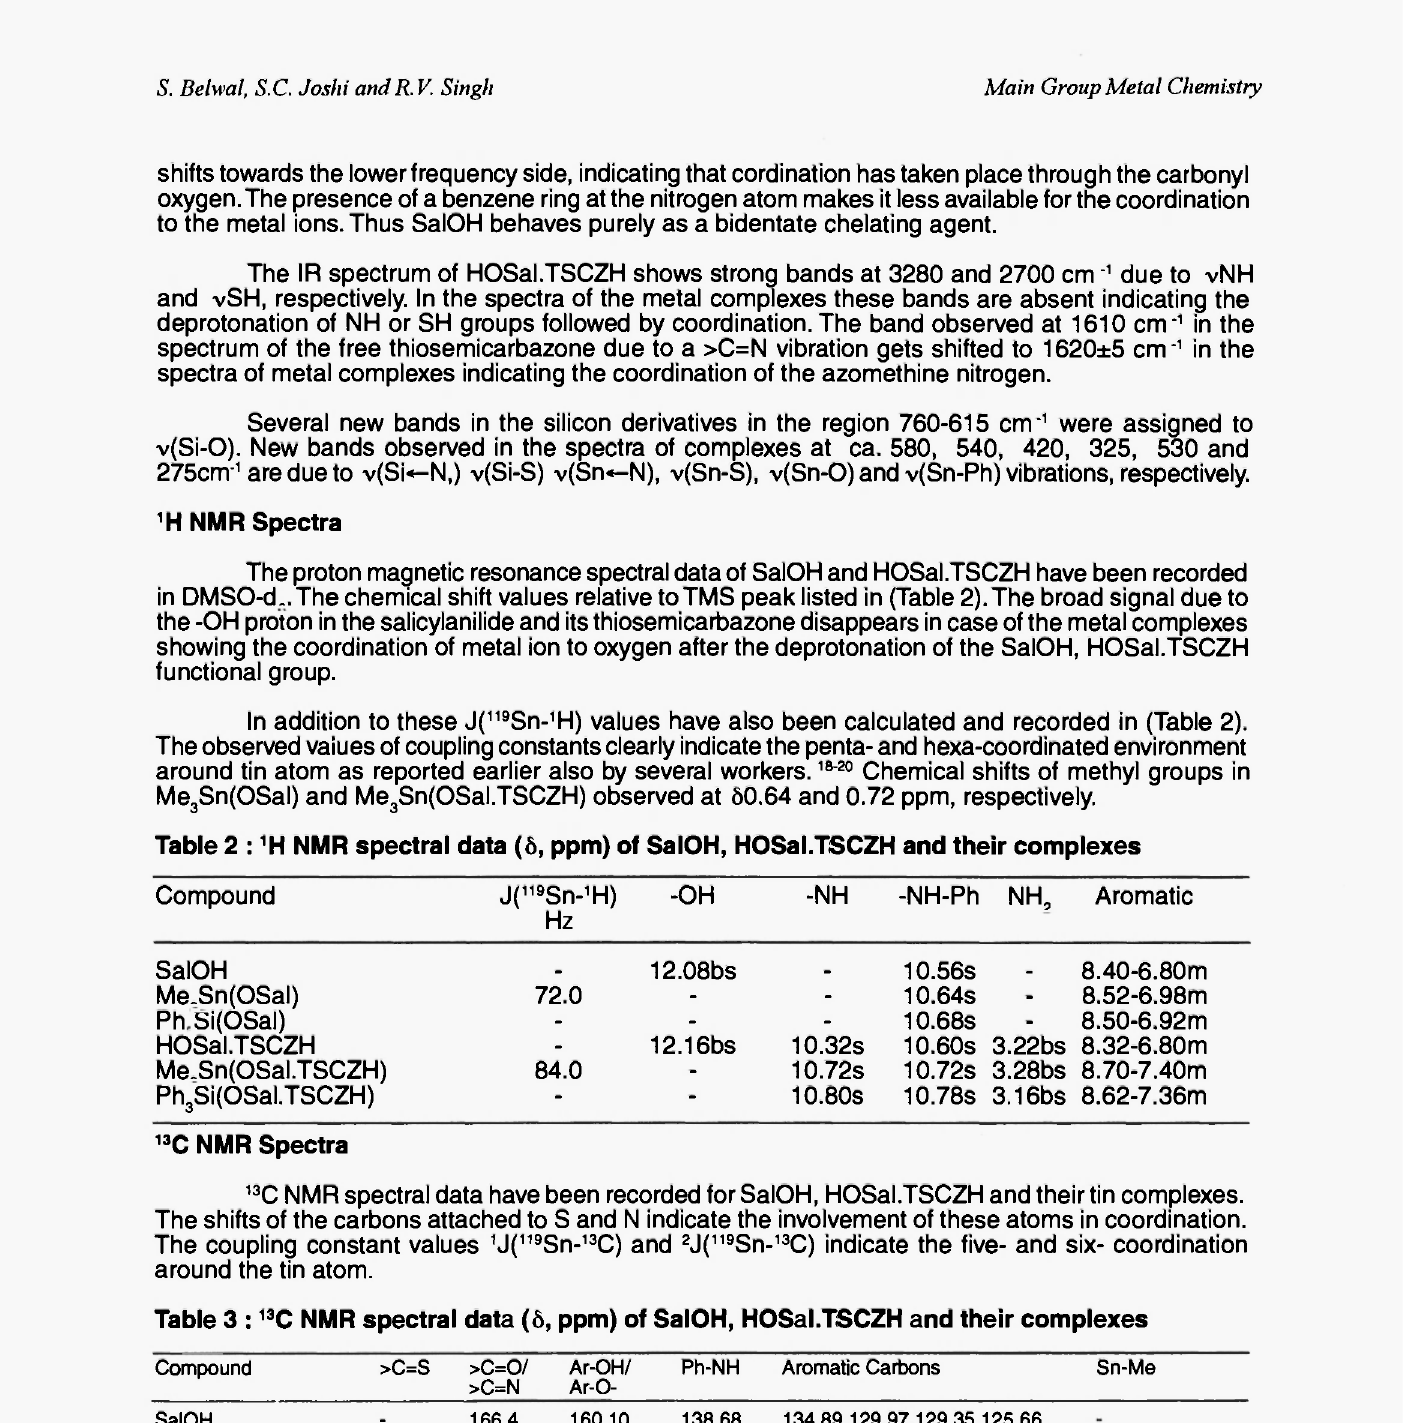
Table 3 : 13 C NMR spectral data (δ, ppm) of SalOH, HOSal.TSCZH and their complexes